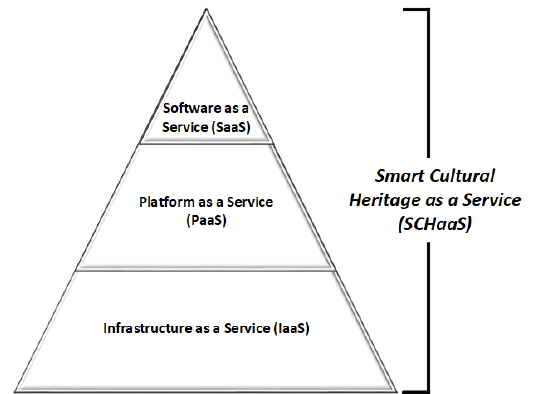
Figure 5. The Smart Cultural Heritage as a Service (SCHaaS) model